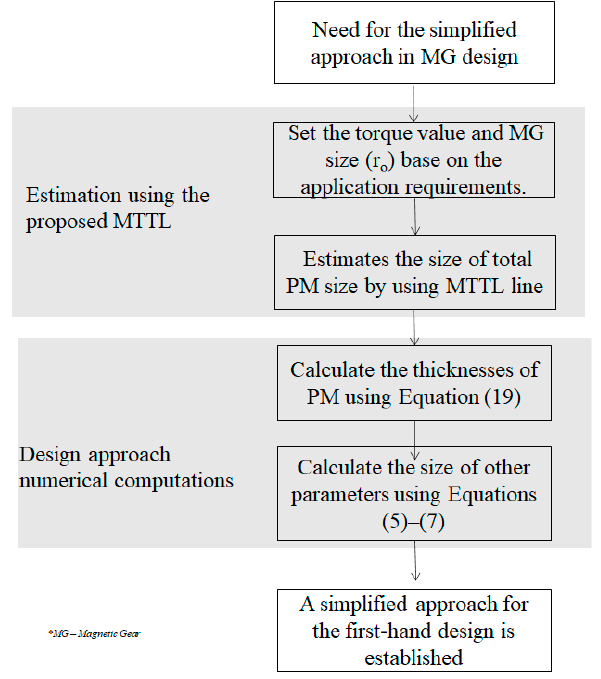
Figure 5. The process of designing a magnetic gear (MG), using the approach.